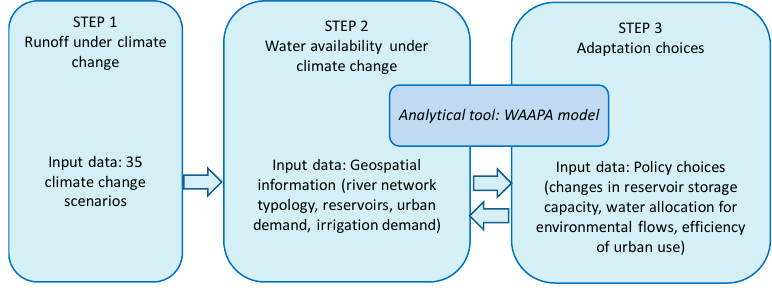
Figure 1. Approach to evaluate scenarios of future water availability for agriculture.